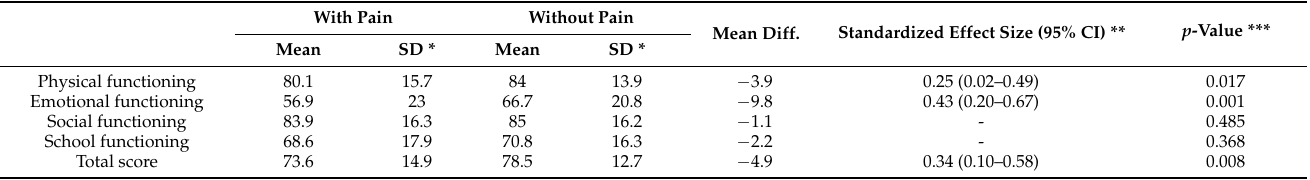
and the group without pain presented means of 80.1 ( ± 15.7) and 84 ( ± 13.9), respectively ( p = 0.017). Table 2. PedsQL scores stratified into two groups: with pain and without pain. With Pain Without Pain Mean Diff. Standardized Effect Size (95% CI)